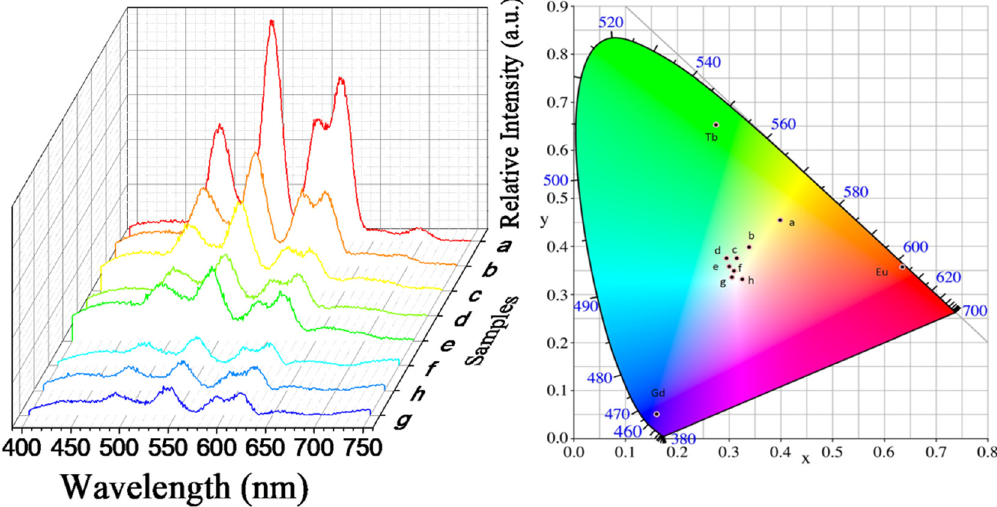
Figure 4: Emission spectra of the doped LMOCP excited at 273 nm. ( a – h ) ( Tb, Eu, Gd% ) : ( a ) ( 1.01, 22.52, 76.47 ) , ( b ) ( 2.34, 3.91, 93.75 ) , ( c ) ( 1.015, 2.075, 96.91 ) , ( d ) ( 1.515, 1.275, 97.21 ) , ( e ) ( 0.015, 1.075, 98.91 ) , ( f ) ( 0.1, 0.5, 99.4 ) , ( g ) ( 0.15, 0.85, 99.0 ) , and ( h ) ( 0.1, 0.9, 99.0 )